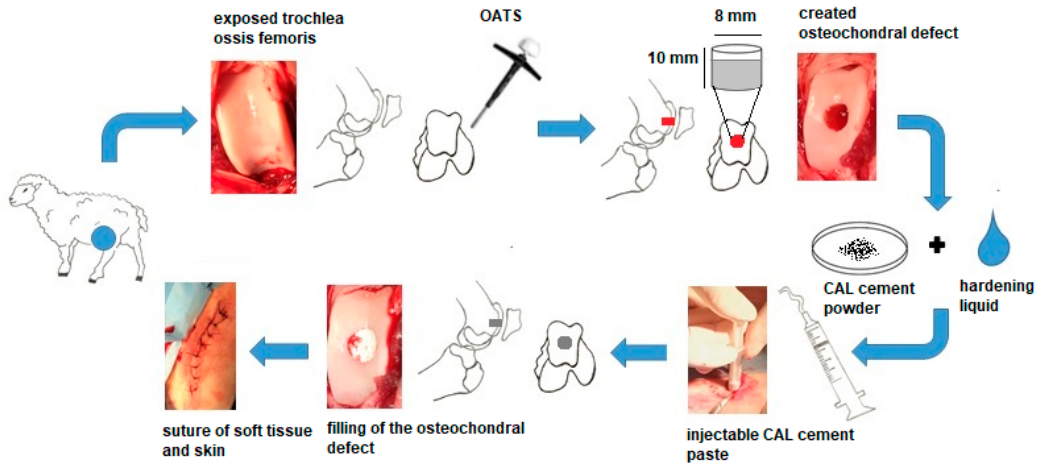
Figure 1. The scheme of the surgical procedure.